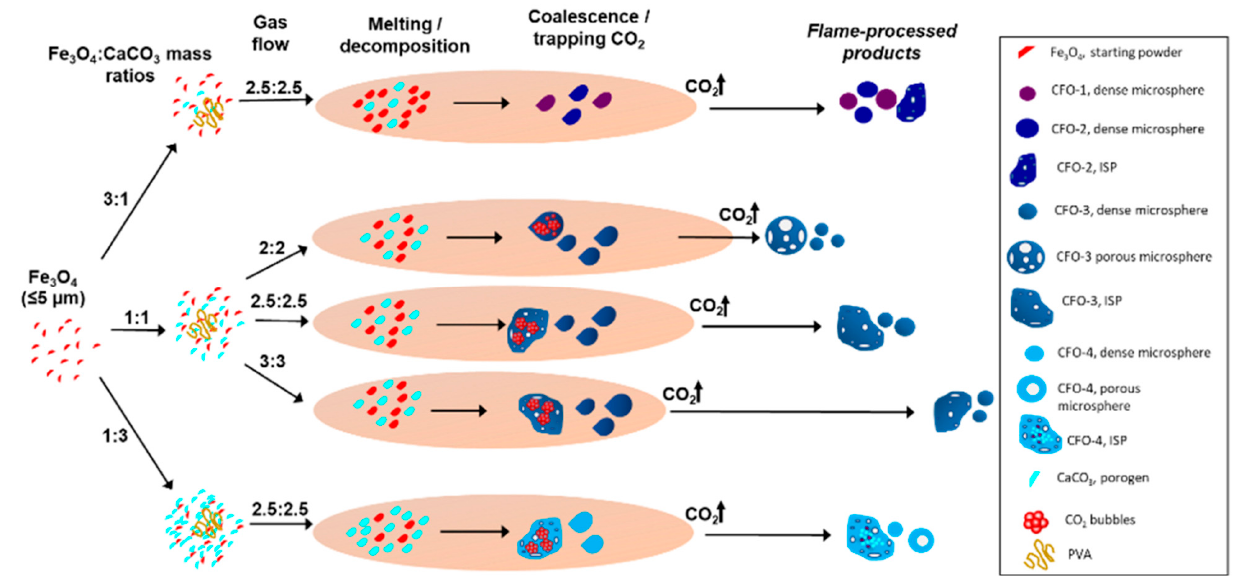
Figure 9. Flame spheroidisation of Fe 3 O 4 :CaCO 3 microsphere products, as a function of mass ratio and gas fl ow se tt ings.